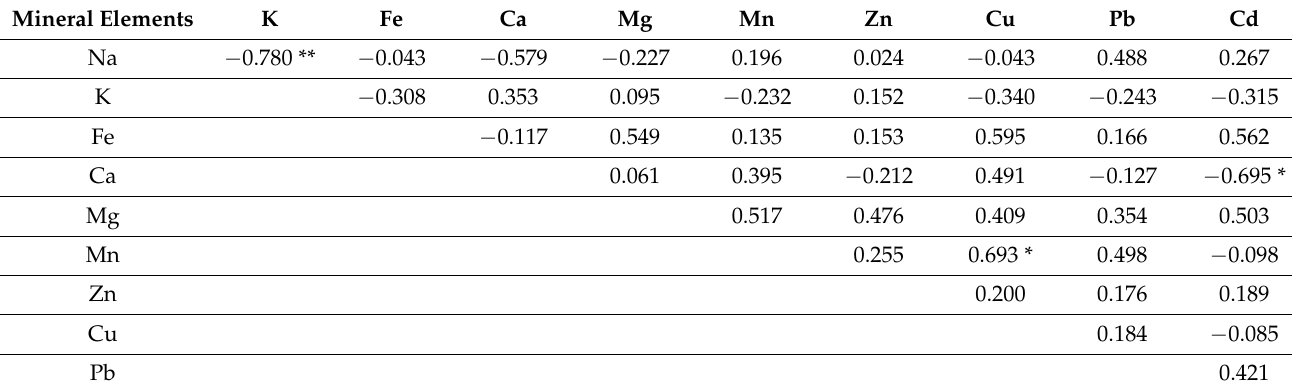
Table 8. Correlation coefficients (r xy ) for the levels of selected mineral elements and toxic metals in the kidneys of red deer. Mineral Elements